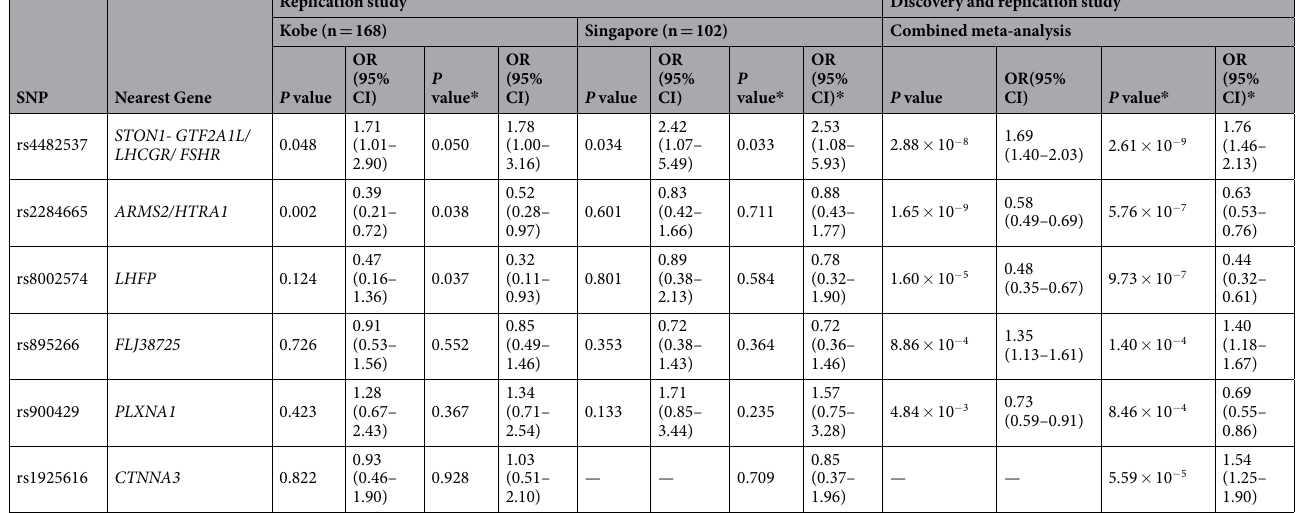
Table 3. Results of two replication studies and meta-analysis for the six loci associated in discovery study, comparing bilateral neovascular age-related macular degeneration cases with unilateral those. SNP, single nucleotide polymorphism; OR, odds ratio; CI, confidence interval. * Adjusted for age and sex.